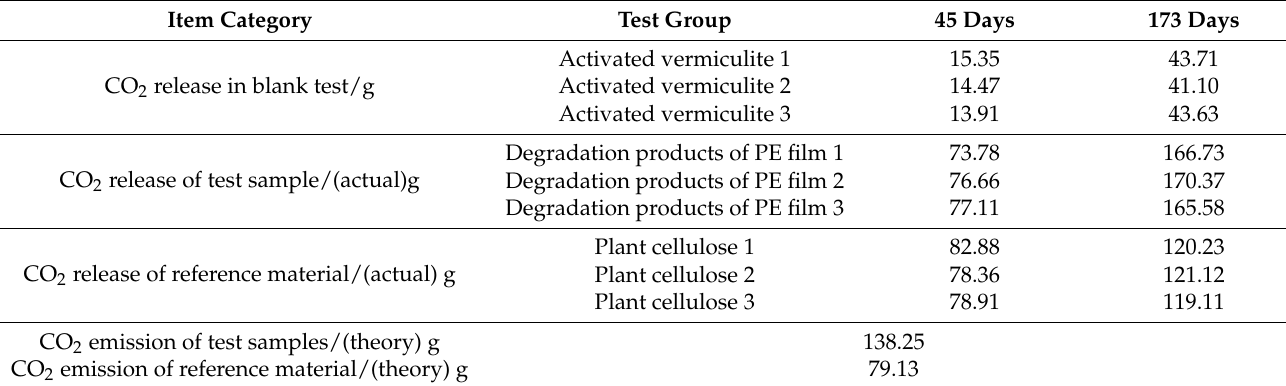
Table 4. Carbon dioxide